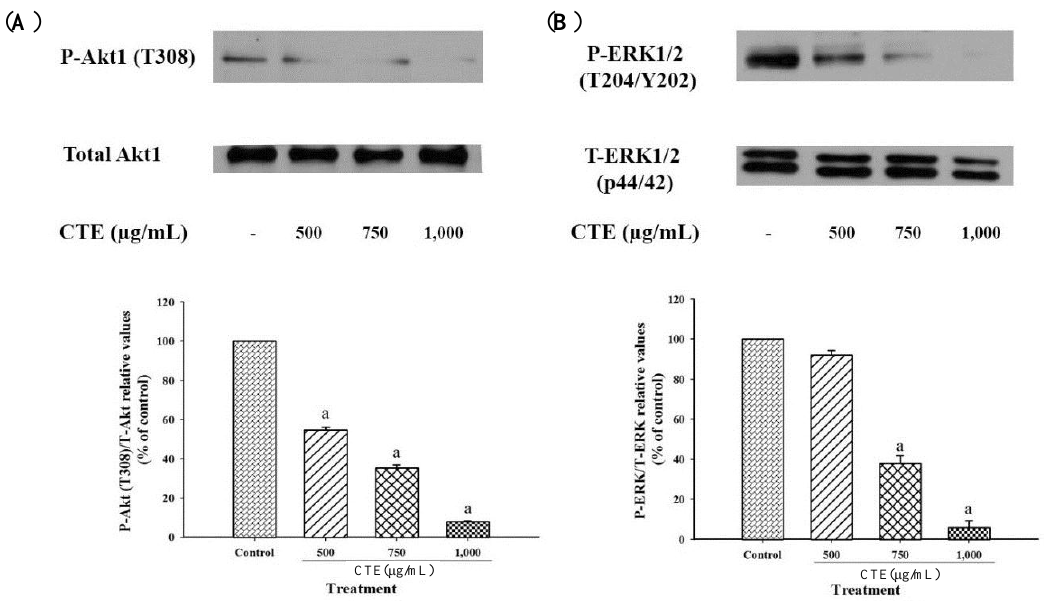
Figure 5. Effects of CTE on Akt ( A ) and ERK ( B ) pathway of 3T3-L1 cells at day 9. The relative values of P (phospho)-Akt1 (T308) to T (total)-Akt1 and P-ERK1/2 (T204/Y202) to T-ERK are shown in % of control. Each value represents the mean ± SEM ( n = 3). a p < 0.05 compared with the control group.